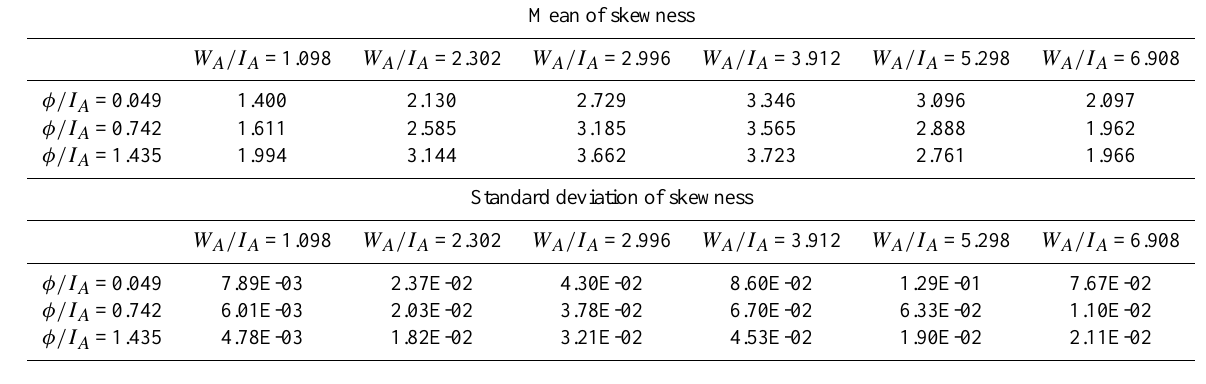
Table 9. Mean and standard deviation of skewness for r L =0.1, r H =0.9; A ranges from 10 to 500km 2 and I 1 ranges from 10 to 50mmh − 1 .